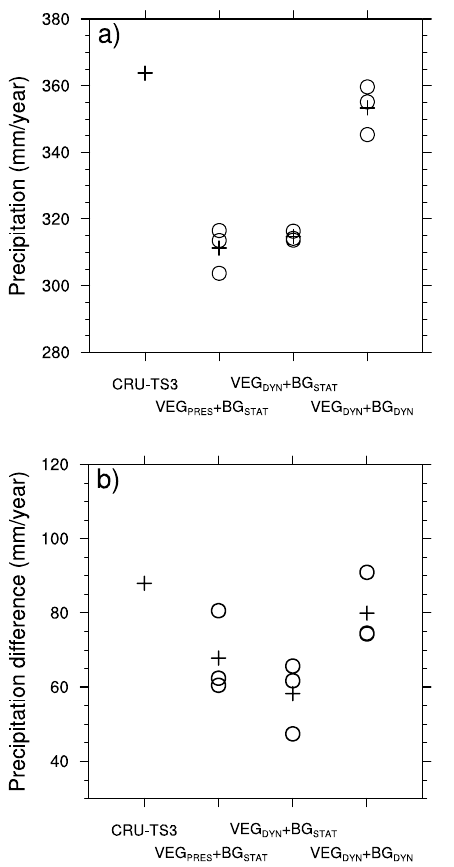
Fig. 4. Annual mean precipitation normalised with regard to mean and the standard deviation of rainfall for the years 1901–2006 in the Sahel. (a) Observed precipitation from the CRU-TS3 land data set (Mitchell and Jones, 2005): bars show yearly values, lines show 5yr running averages. Simulated precipitation for the (b) static (VEG PRES + BG STAT ) simulations, (c) dynamic vegeta- tion (VEG DYN + BG STAT ) simulations, and (d) dynamic vegetation and dynamic albedo (VEG DYN + BG DYN ) simulations. Bars show annual values of the ensemble mean. Lines show 5yr running aver- ages for the individual ensemble members (grey) and the ensemble mean (black). The dotted lines indicate one standard deviation from the